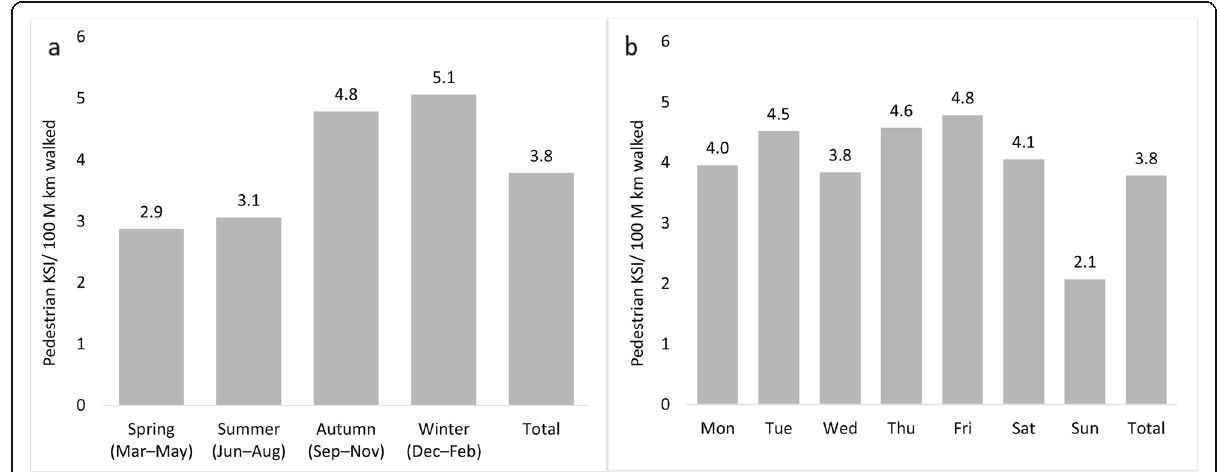
Fig. 4 Pedestrian KSI rate according to ( a ) season and ( b ) day of the